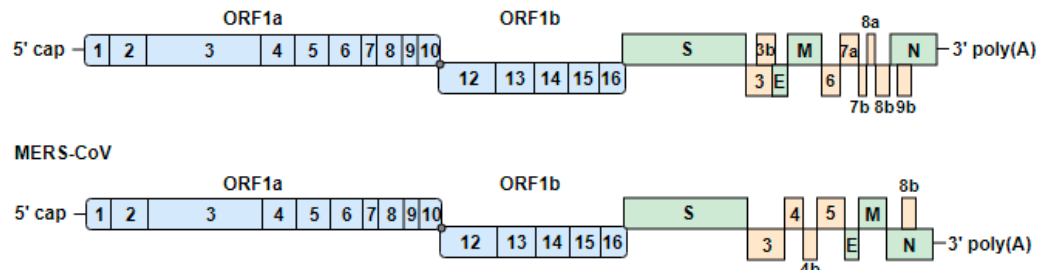
Figure 2. Genome organization of severe acute respiratory syndrome coronavirus (SARS-CoV) and Middle East respiratory syndrome-CoV (MERS-CoV). The genomes encode two large open reading frames (ORF1a and ORF1b), which contain 16 nonstructural proteins (1 to 16). ORF1b is transcribed after a − 1 ribosomal frameshift (gray dot). The structural proteins (S, spike; E, envelope; M, membrane; N, nucleocapsid) and accessory proteins are expressed from subgenomic RNAs. Blue, green and yellow indicate the nonstructural, structural and accessory proteins, respectively.